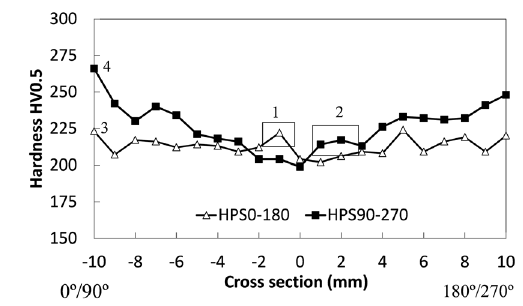
Figure 5. Hardness profiles (HV0.5) over the bar cross section in the section 0°-180° and 90°-270° for horizontal pre-straightened